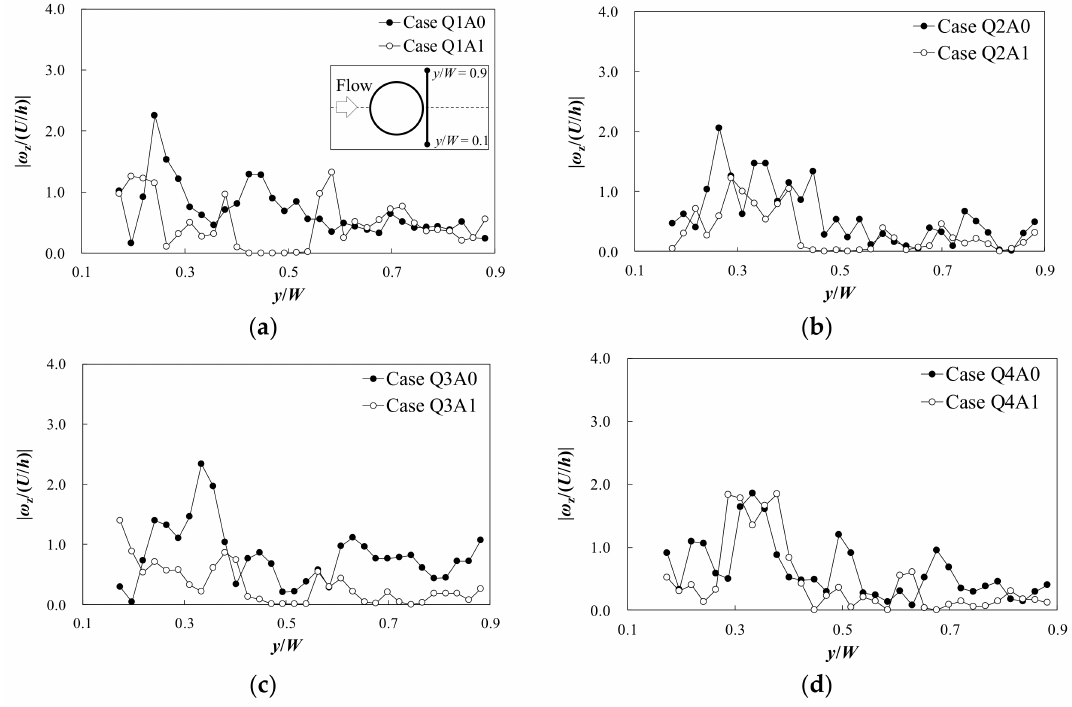
Figure 13. Comparisons of the vorticity distributions at z / h = 0.9: ( a ) Q = 0.018 m 3 /s;